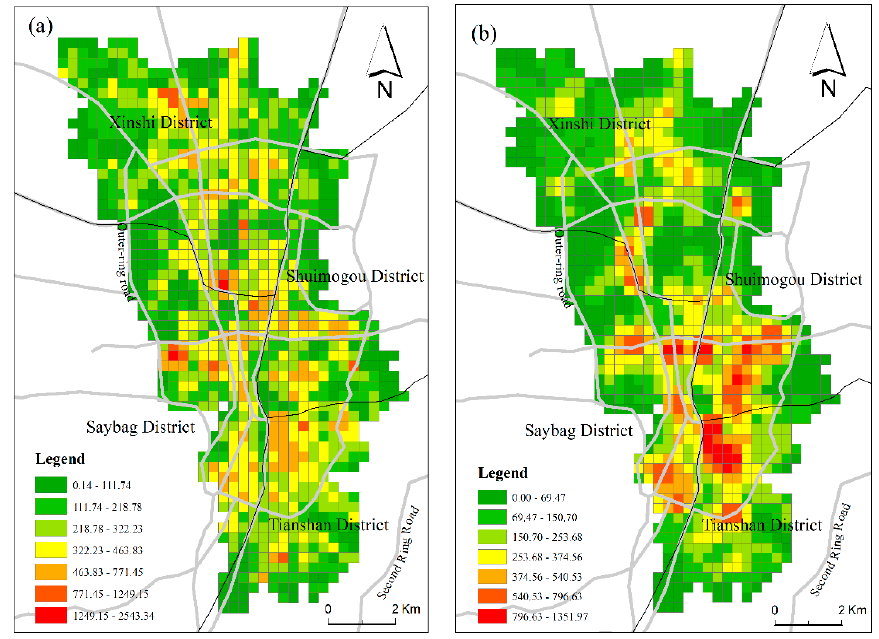
Figure 3. Spatial patterns of urban vibrancy in Urumqi: ( a ) RPD derived vibrancy; ( b ) SCB derived vibrancy. Further spatial autocorrelation analysis was performed on two vibrancy levels. Global